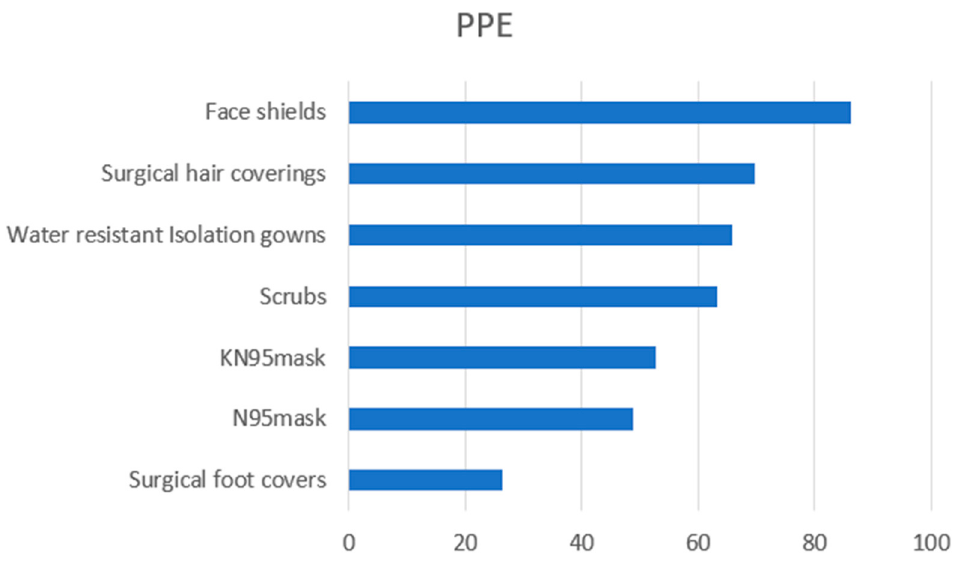
Figure 2. Personal Protective Equipment (PPE) used since